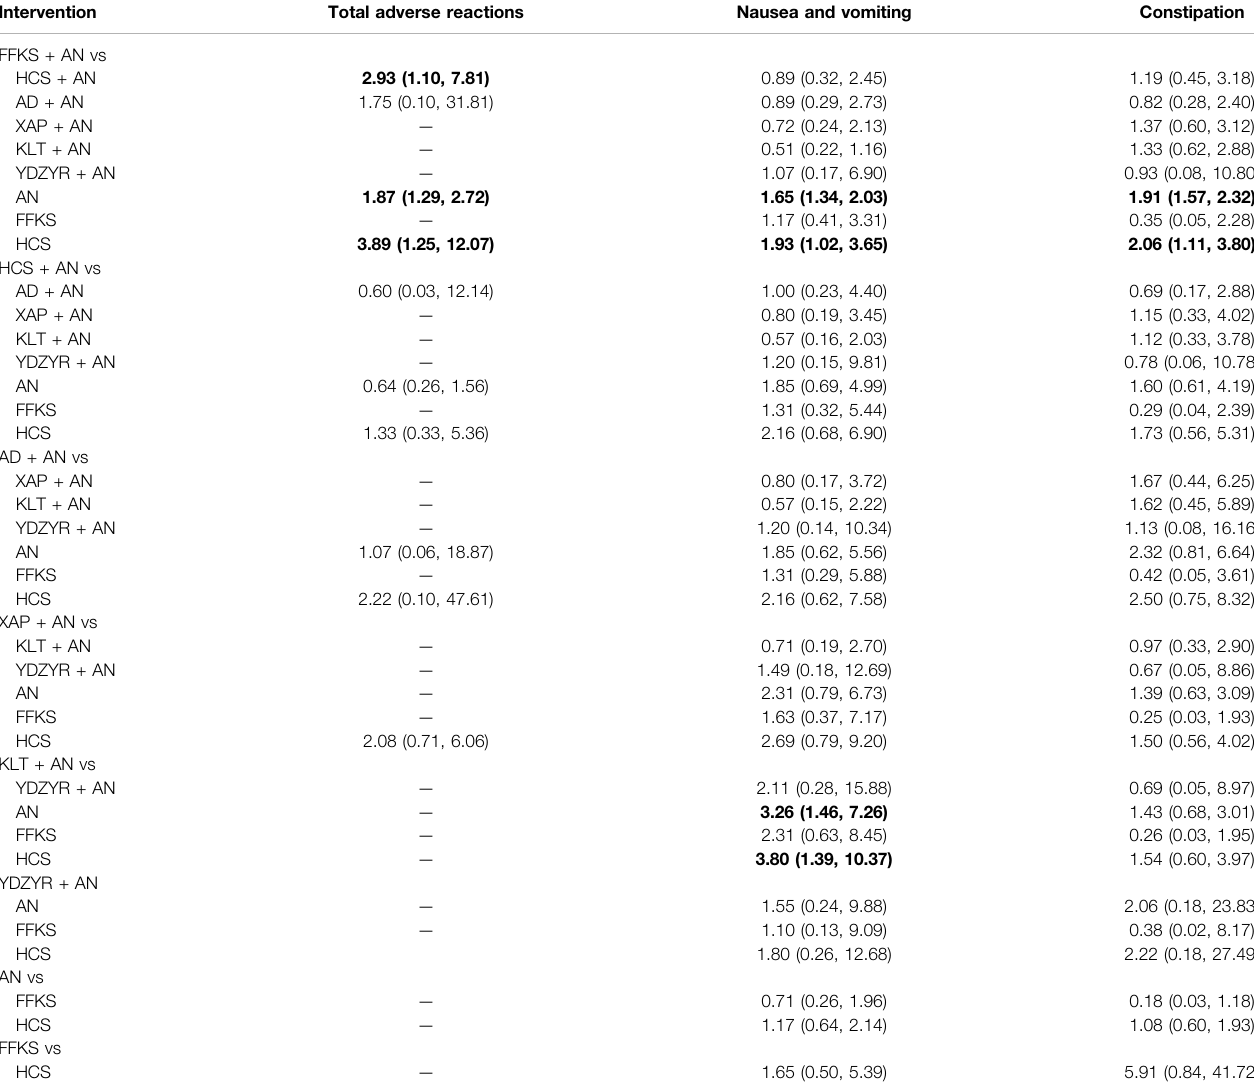
Note: Bold results indicate statistically signi fi cant differences between groups. FFKS + AN, Fufangkusheninjection + analgesic;HCS + AN, Huachansu injection+ analgesic; AD + AN, Aidi injection + analgesic;XAP + AN, Xiaoaipinginjection + analgesic;KLT + AN, Kanglaite injection + analgesic; YDZYR + AN, Yadanziyouru injection + analgesic; AN, analgesic; FFKS, fufangkushen injection; HCS, huachansu